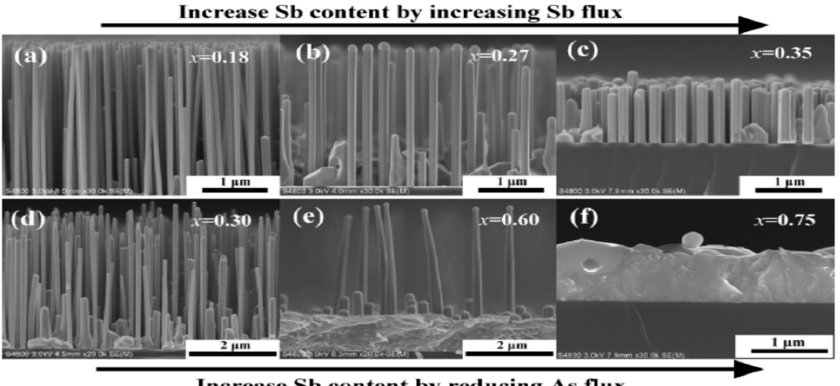
Figure 2. Side-view SEM images of the Ga self-catalyzed GaAs 1 − x Sb x nanowires grown on Si (111) substrates by molecular beam epitaxy (MBE). ( a – c ) GaAs 1 − x Sb x nanowires were obtained by increasing